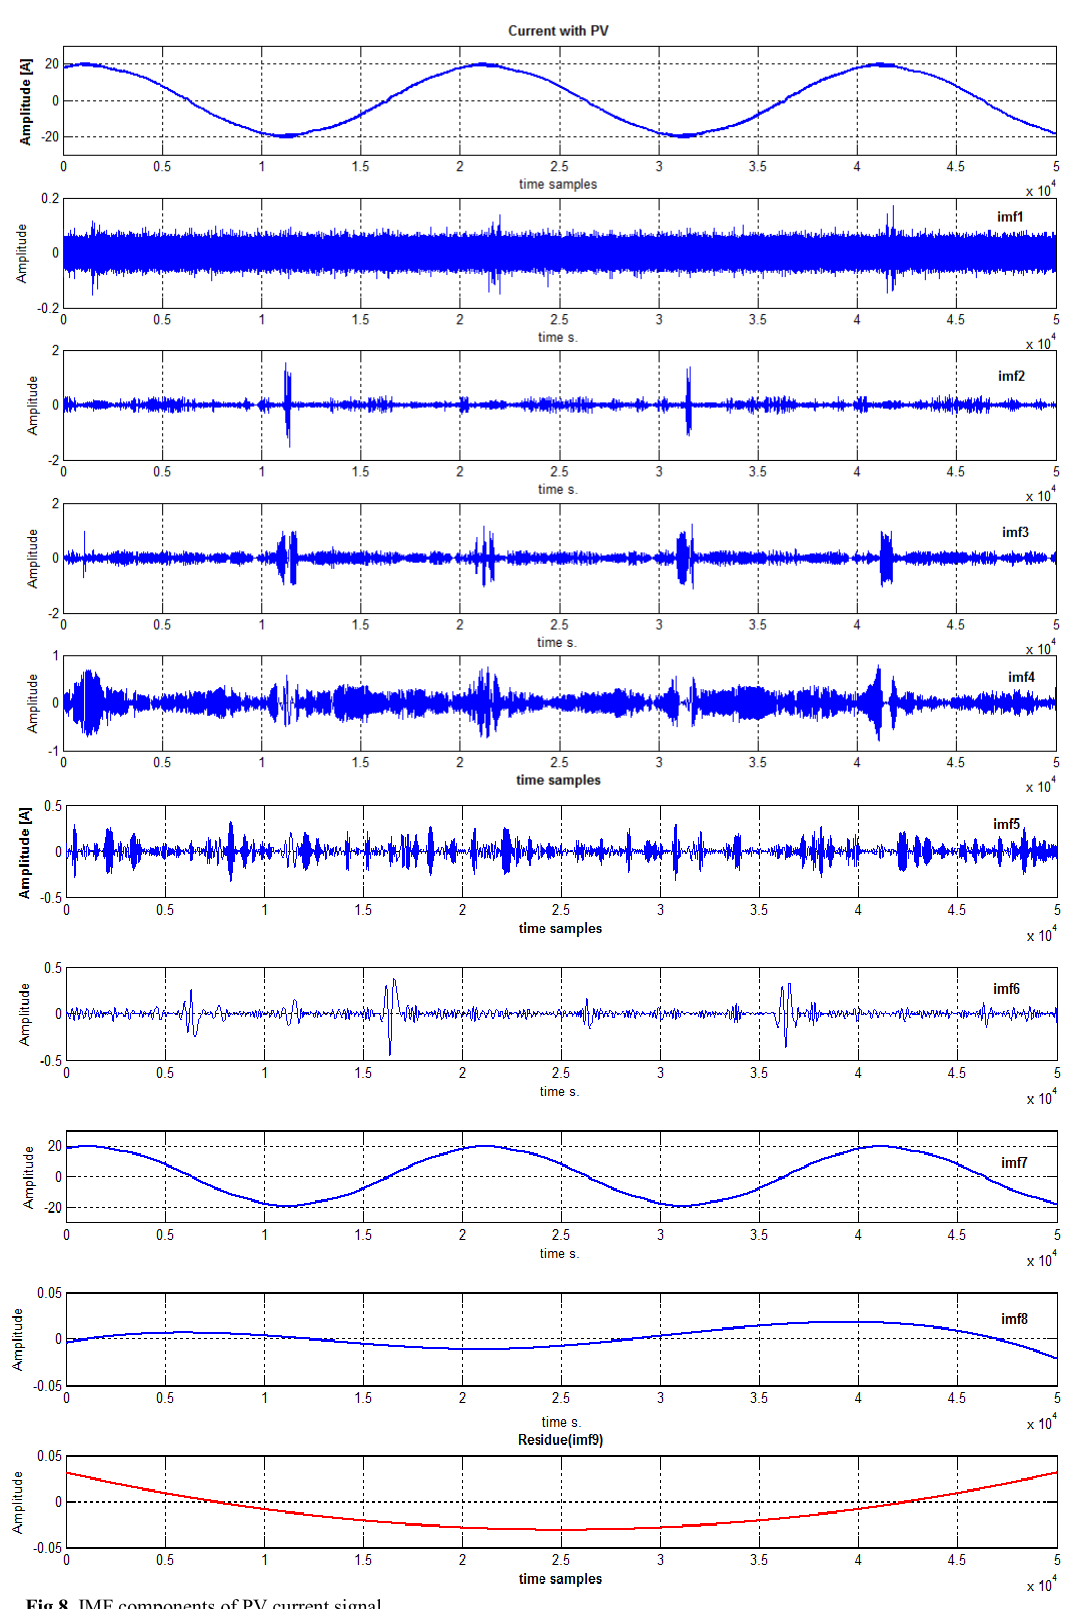
Fig 8. IMF components of PV current